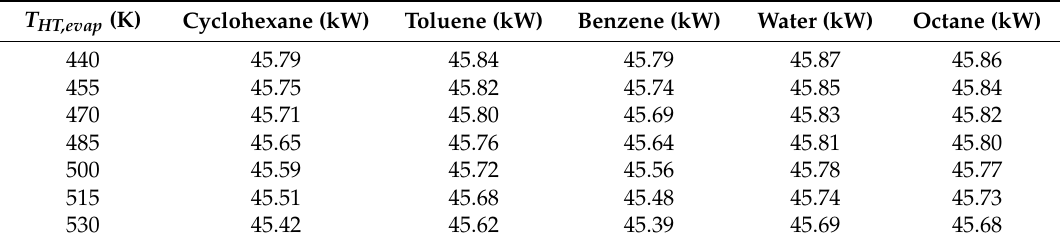
Table 6. Variation of heat consumed by the HT cycle of novel dual-loop TLC-ORC system. T HT,evap (K)